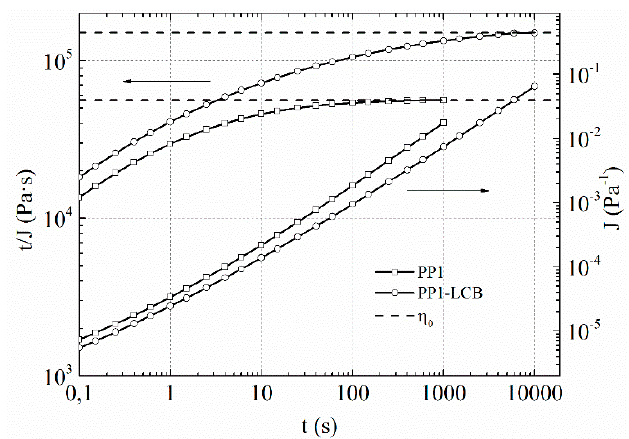
Figure 3. Creep experiments and determination of η 0 .